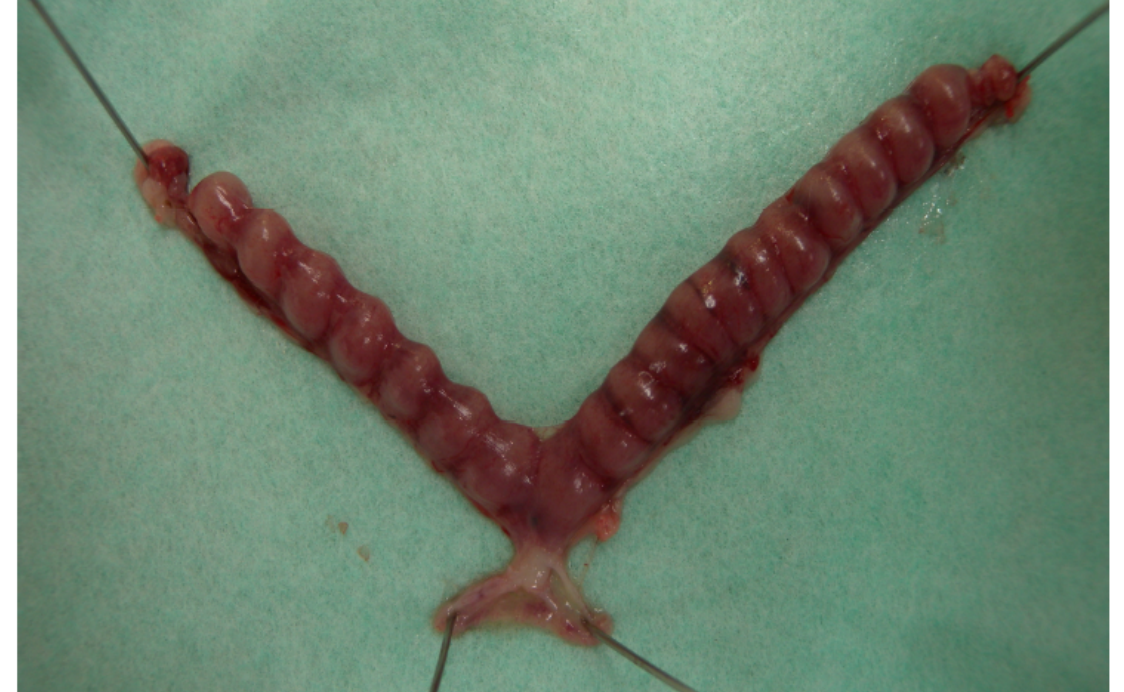
Figure 1. Equidistance of implantation sites in the murine uterus. In the pregnant murine uterus, the implantation sites are regulated equidistantly in response to numbers of implanting